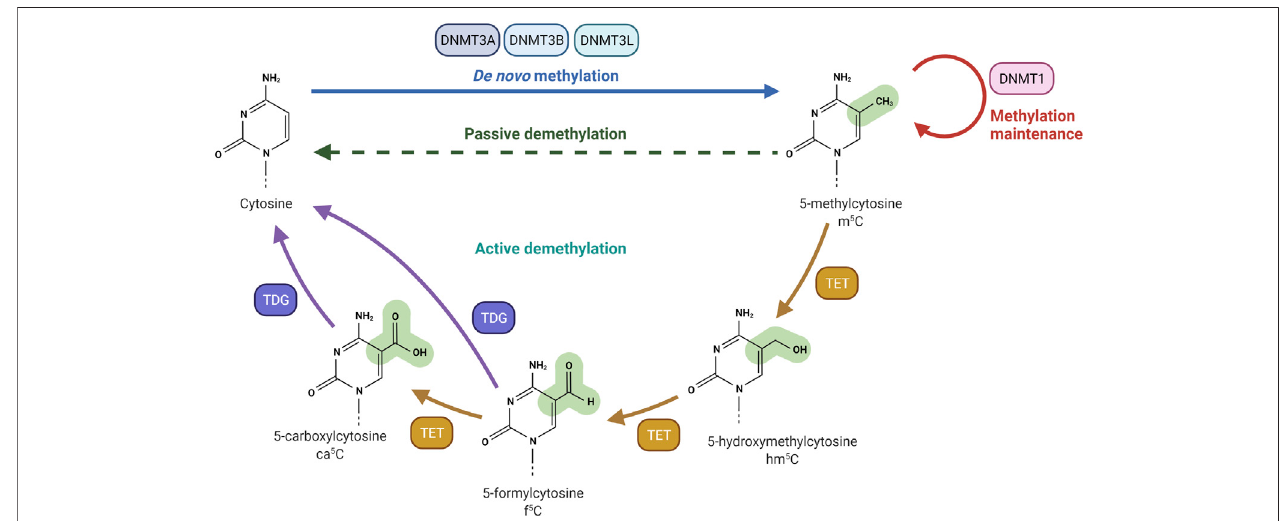
FIGURE 1 | DNA methylation and demethylation machinery. DNA methyltransferase 3A (DNMT3A) and DNA methyltransferase 3B (DNMT3B) are responsible for the creation of DNA methylation patterns. DNA methyltransferase 3L (DNMT3L) interacts and stimulates DNMT3A and DNMT3B methylation activity. DNA methyltransferase 1 (DNMT1) is actively involved in the maintenance of DNA methylation patterns. Passive demethylation occurs in the absence of functional DNMT1, which methylates DNA after each cellular division. Active demethylation is mediated by Ten-eleven Translocation (TET) dioxygenases. TET enzymes oxidize